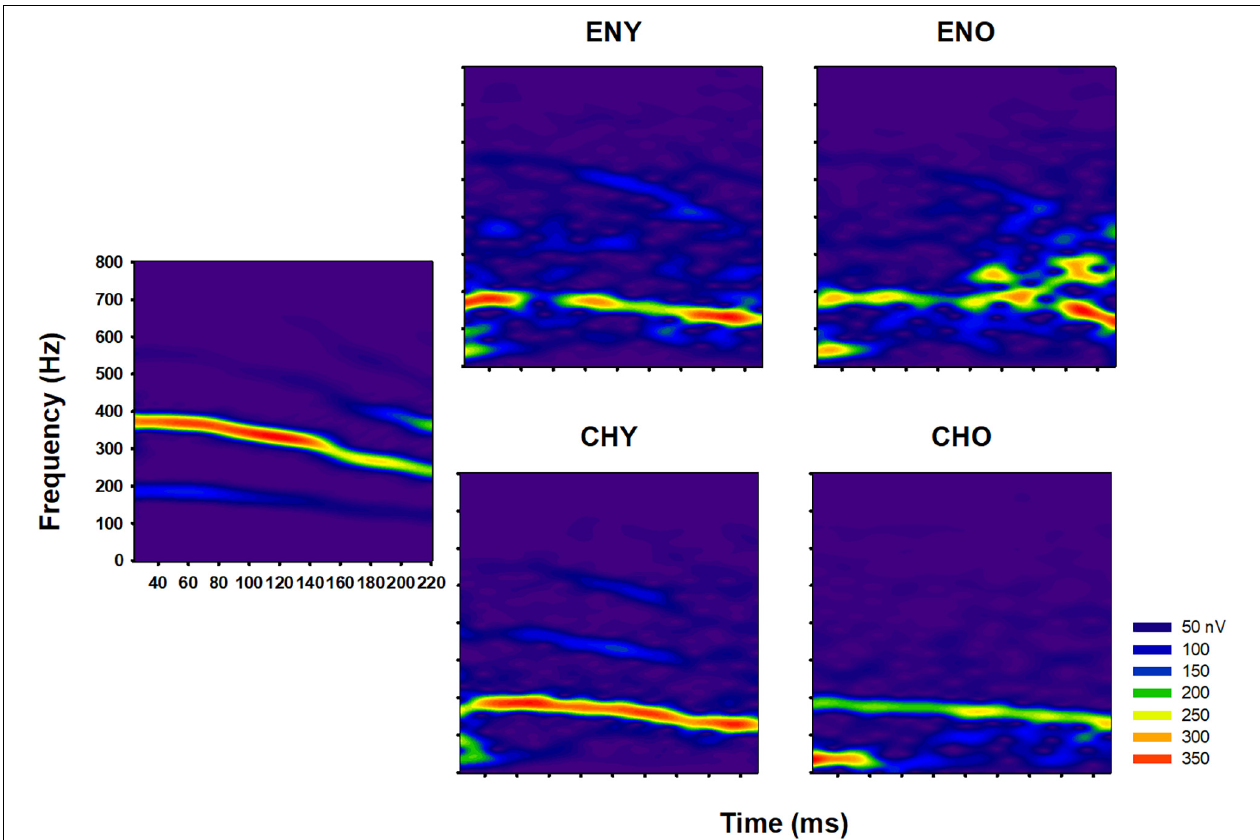
FIGURE 2 | Comparison of FFR spectrograms in different groups. Spectrograms of the original stimulus/yi4/( left panel ) and of the grand-average of FFR of all four groups ( right panel ). Spectrograms were plotted in Frequency (in Hz) as a function of Time (ms) and the colored heatmap represents spectral energy